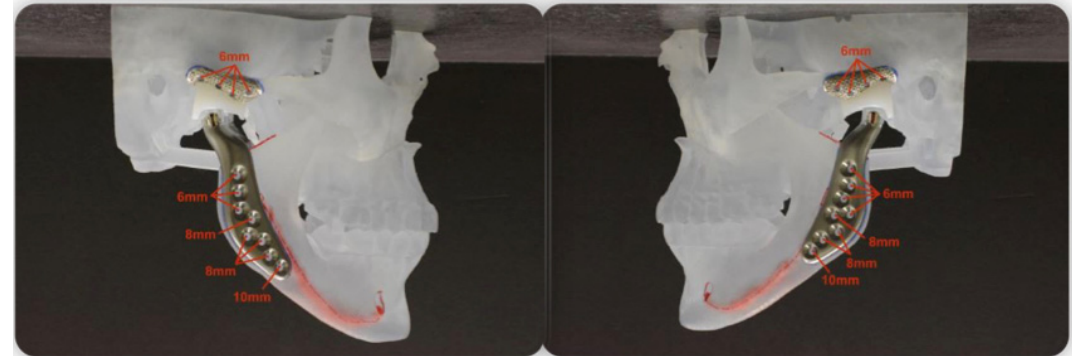
Figure 1. TMJ concept for total joint replacement of fossa and mandibular component.